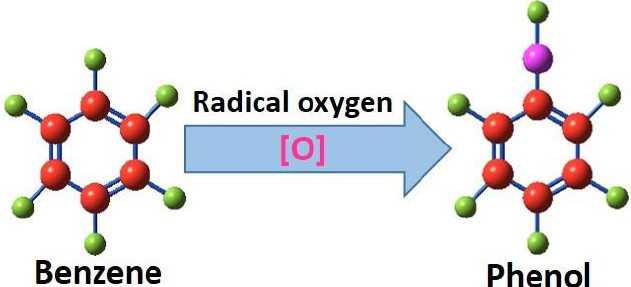
Figure 4. The schematic of reaction involved in the radical quenching by the aromatic ring to form functional group instead of ring cleavage.